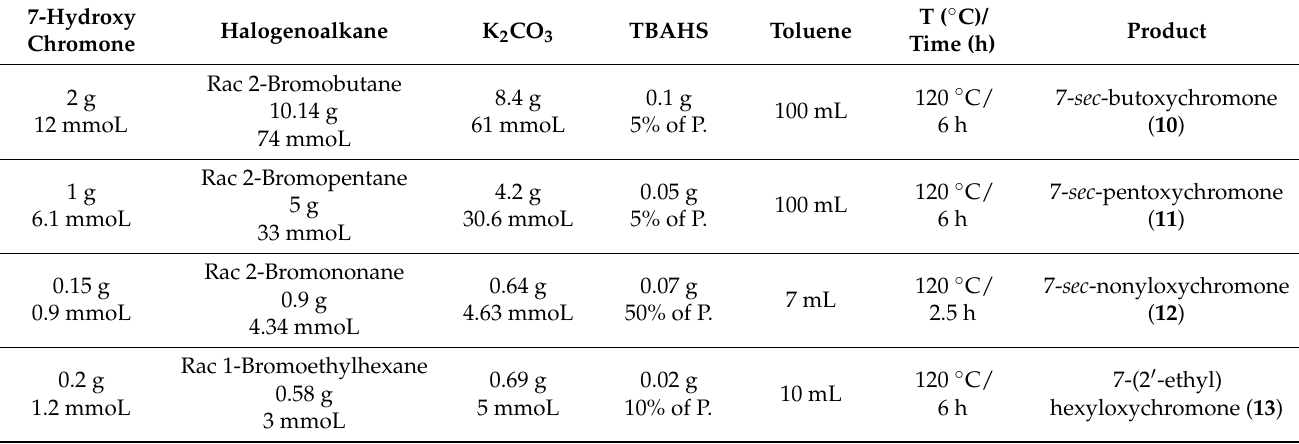
Conditions of the synthesis of racemic 7- sec -butoxychromone ( 10 ), 7- sec -pentoxychromone ( 11 ), 7- sec - nonyloxychromone ( 12 ), and 7-(2 (cid:48) -ethyl)hexyloxychromone ( 13